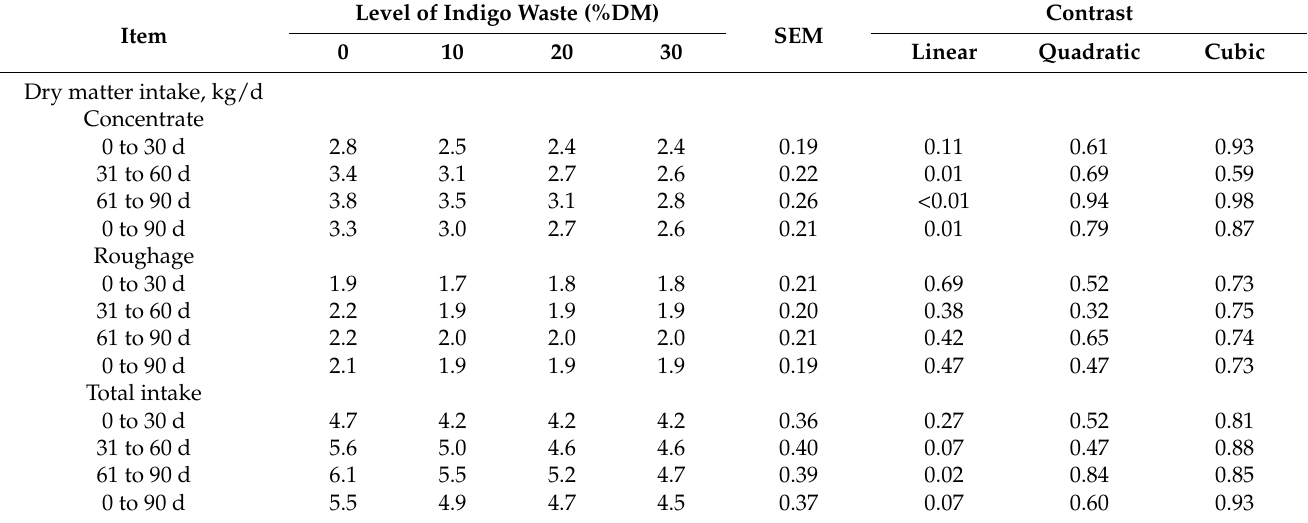
Table 4. Effect of indigo waste on feed intake in growing beef cattle.